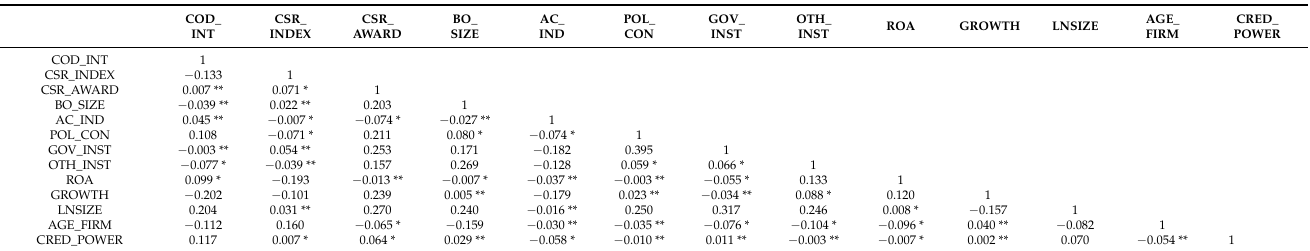
Table 3. Correlation analysis (Pearson correlations